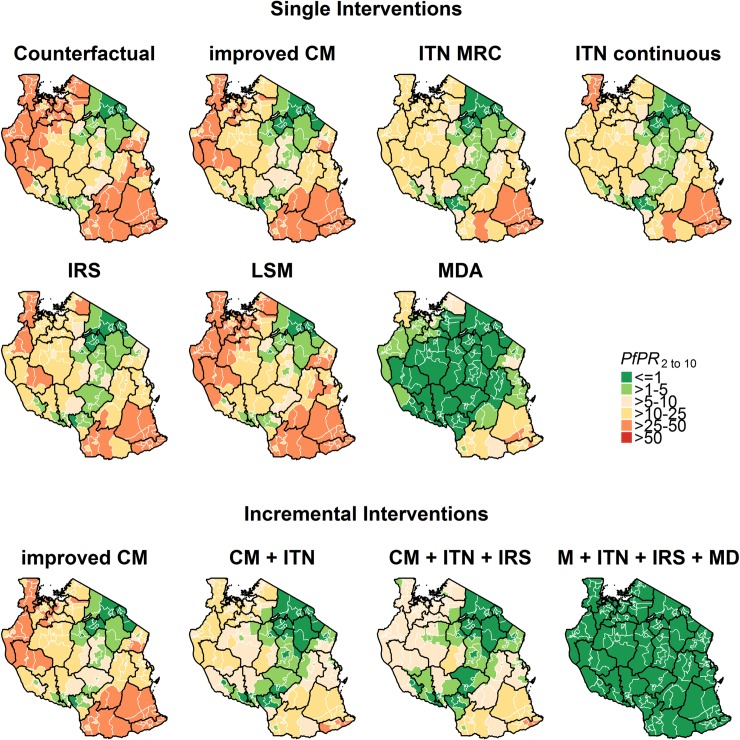
Simulated prevalence in 2020 for single and incremental intervention scenarios between 2017 and 2020.Each map shows the 2020 council-specific predicted prevalence for the age-group 2–10 years, resulting from the scale-up of every single intervention, or selected combinations of interventions. The interventions scenarios shown visualise blanket distributions, with the same intervention scenario for all councils.